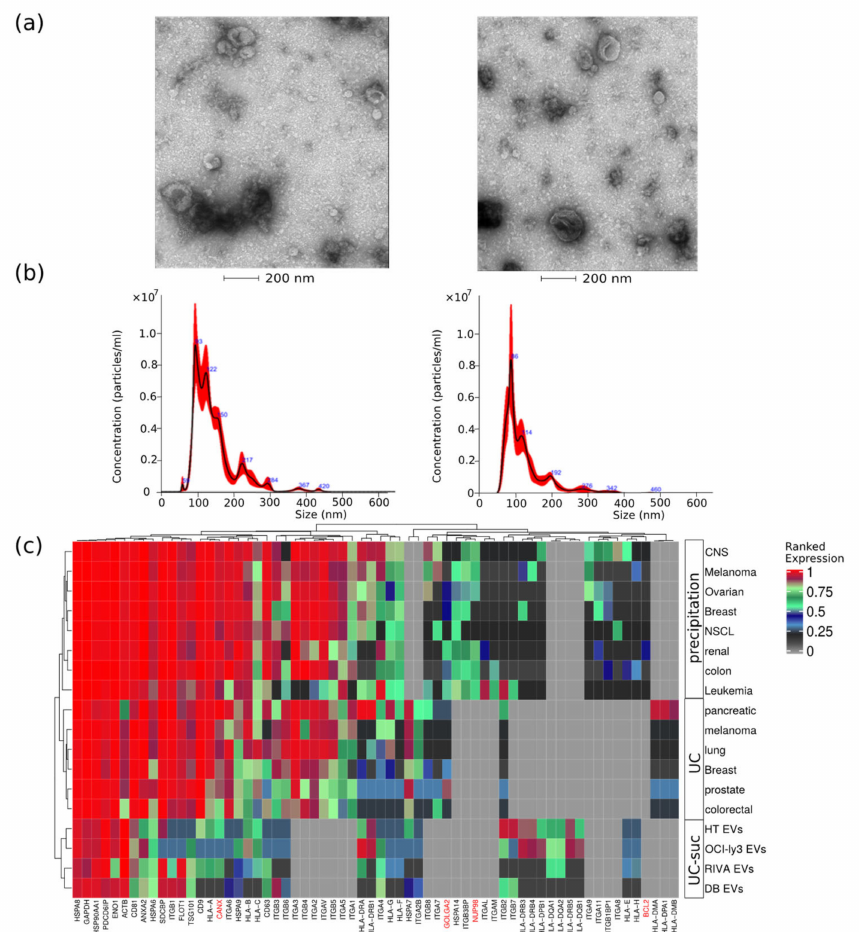
Figure 1. EVs quality control assessment evaluated by different methods. ( a ) Negative staining transmission electron microscopy (TEM); ( b ) nanoparticle tracking analysis of representative EV samples; and ( c ) analysis of EVs protein expression values obtained from different cancer cell types using three isolation methods, namely, precipitation, ultracentrifugation (UC), or UC combined with sucrose cushion (UC-suc). Cell organelle markers are indicated in red. Table 1. EVs sample characteristics recorded by nanoparticle tracking analysis. CELL